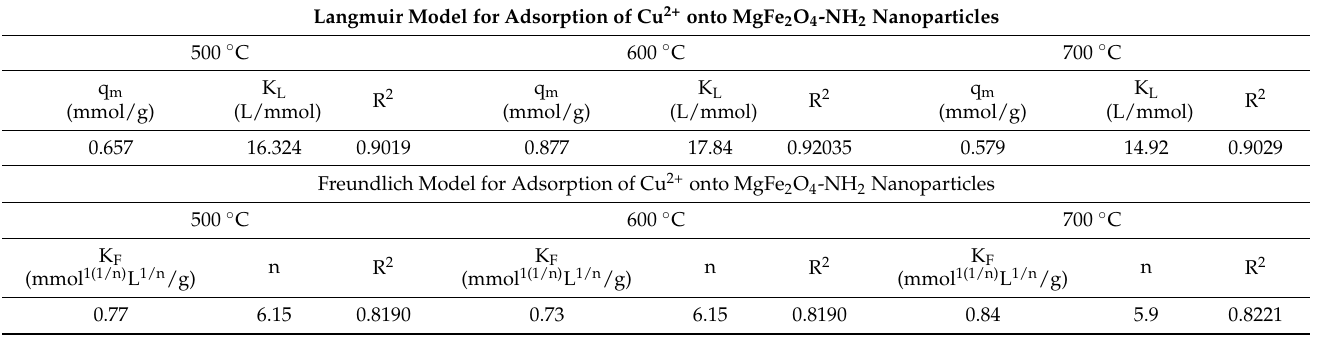
Table 4. Isotherm parameters calculated from Langmuir and Freundlich model.